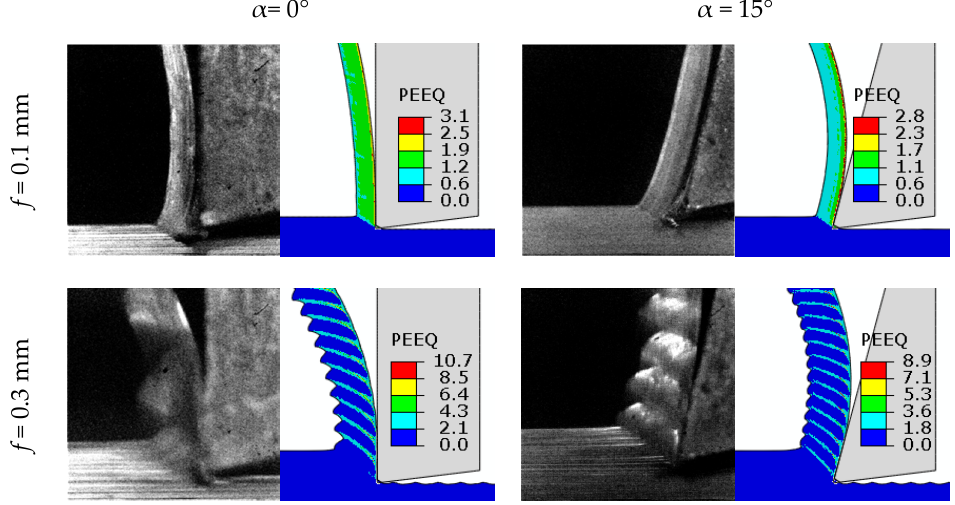
Figure 8. Experimental vs. numerical chips morphology for two feeds and two rake angles.